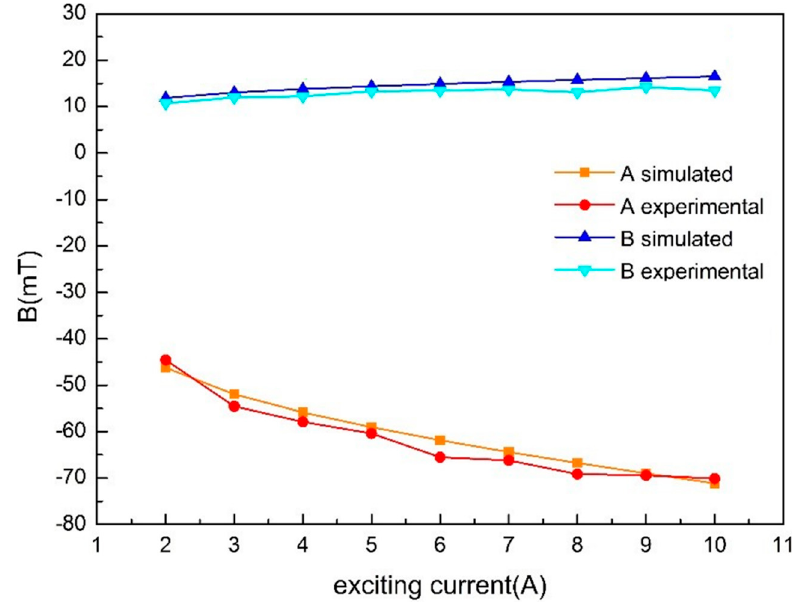
Figure 22. Comparison between simulated and experimental value of magnetic field.